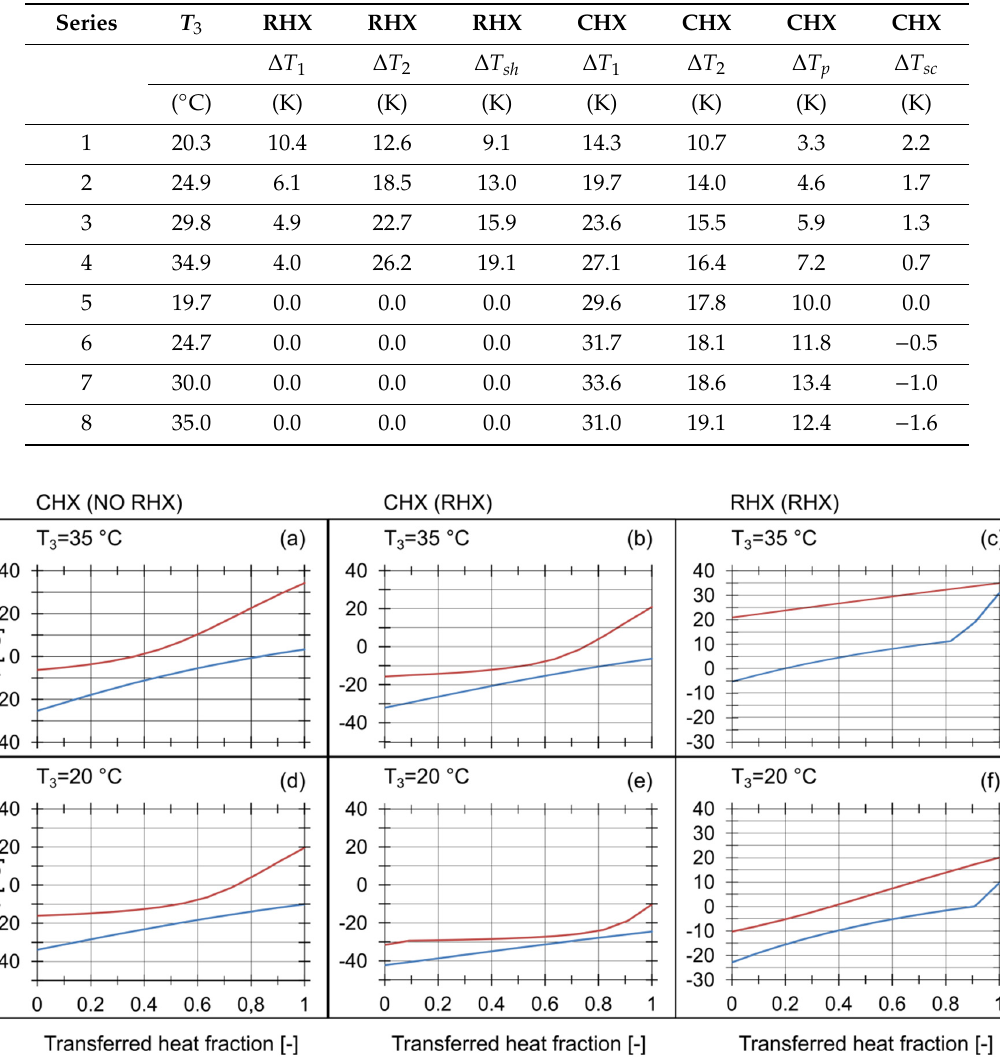
Table 2. Summary of temperature di ff erences across the IHXs.